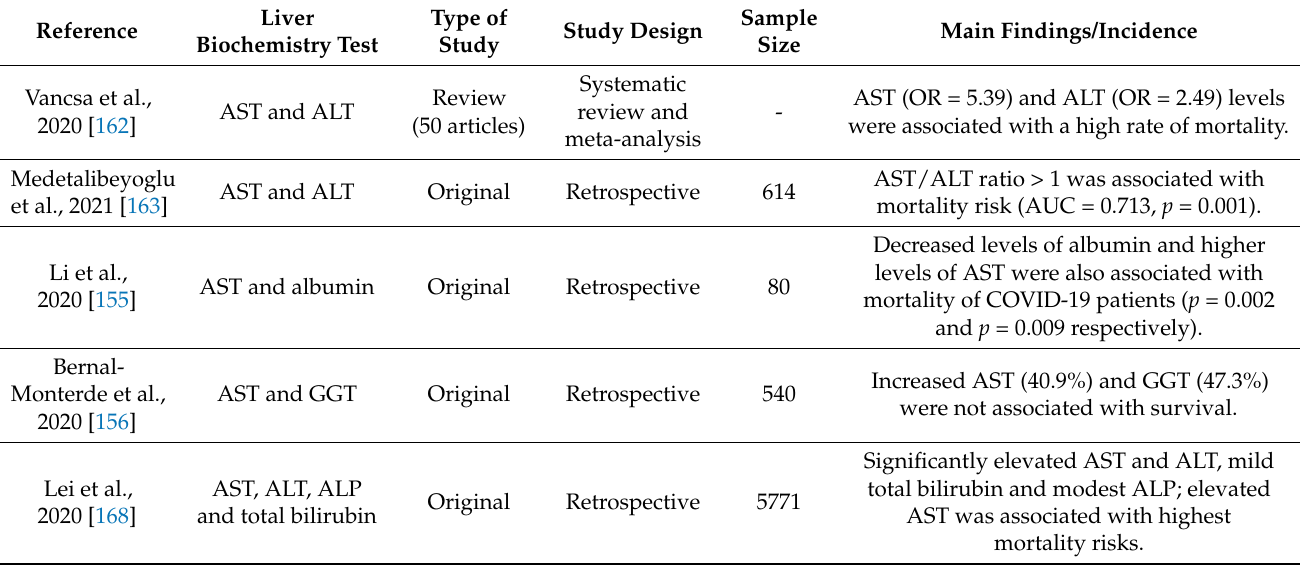
Table 2. Abnormal liver biochemistry tests and clinical outcome (mortality) in COVID-19